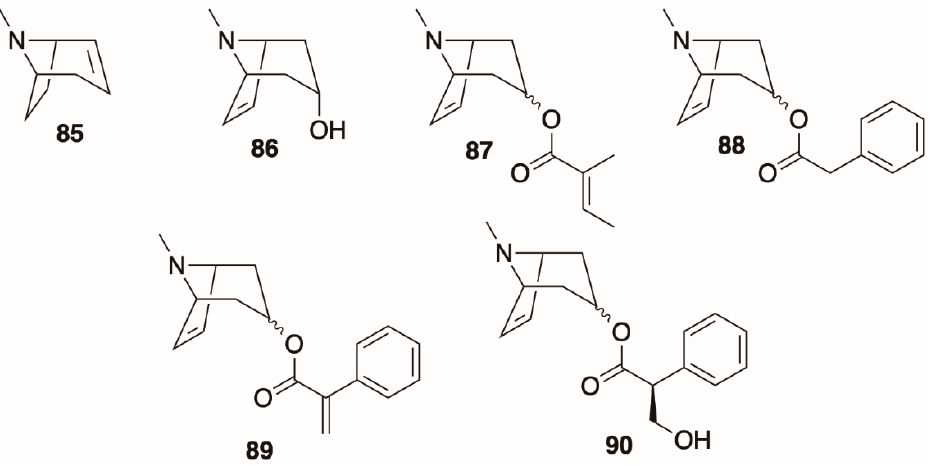
Figure 8. Dehydrotropanes identified in Datura species.